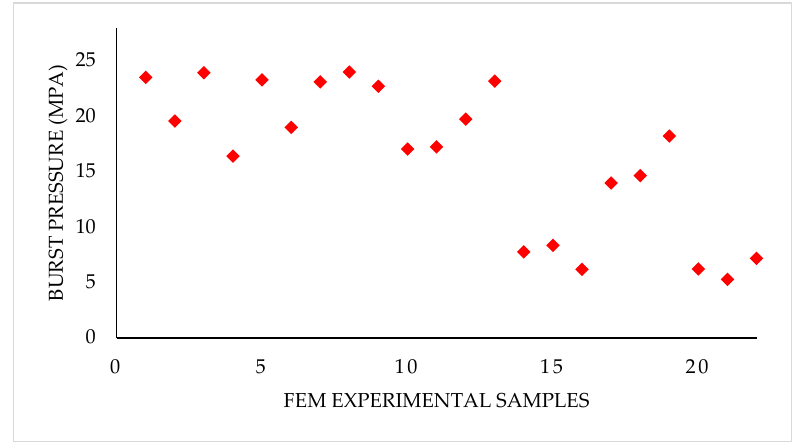
Figure 4. Summary of FEM estimated burst pressures for the pipes—samples 1 to 13 are for X46 (D: 321.56 mm to 324.1 mm), samples 14 to 16 are for X46 (D: 836.6 mm), samples 17 to 19 are for X52 (D: 273.05 mm) and samples 20 to 22 are for X52 (D: 611.35 mm to 612.54